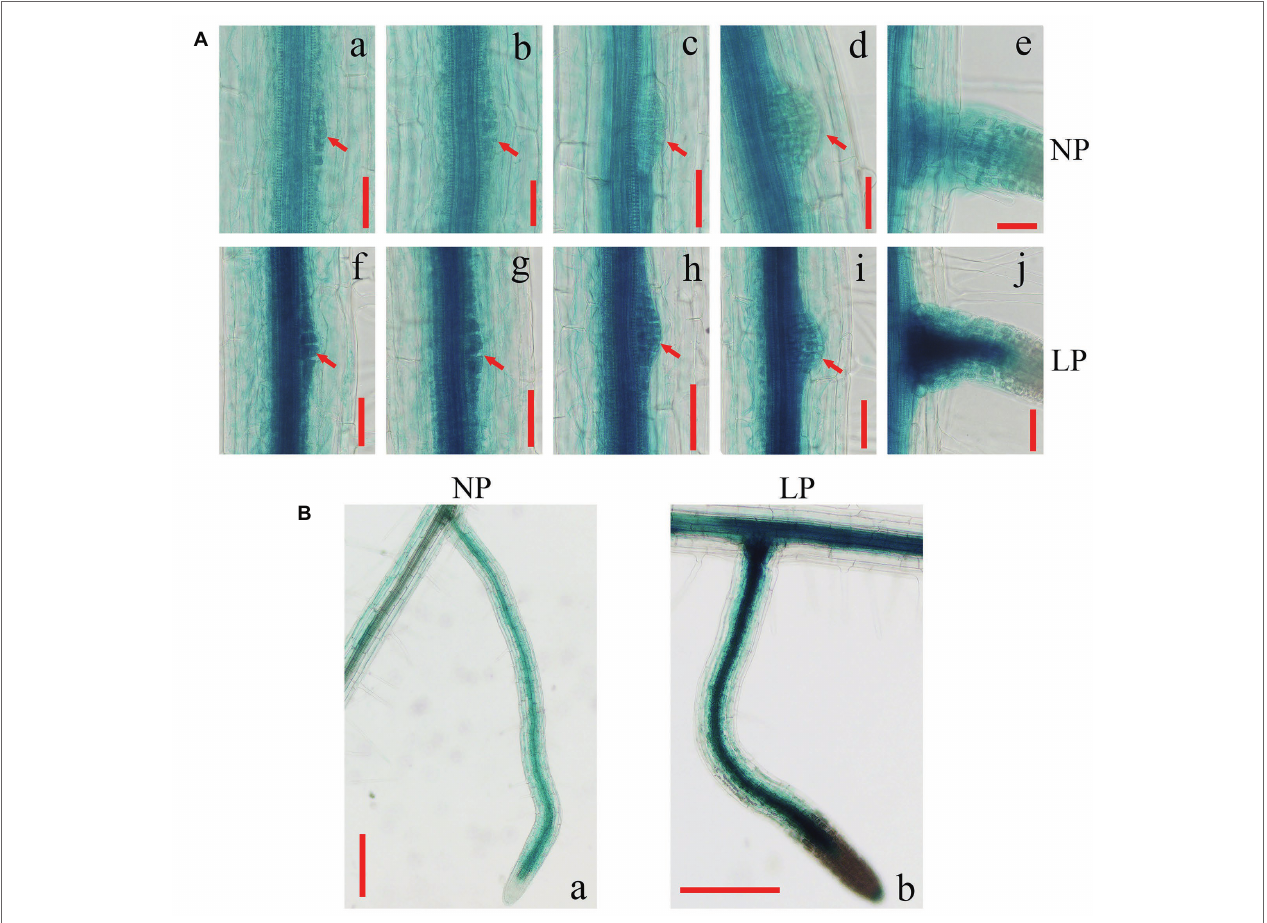
FIGURE 6 | Expression patterns of GmEXLB1::GUS during lateral root development. (A) (a–e) GUS staining at different stages of lateral root emergence in transgenic Aradidopsis under NP conditions (f–j) GUS staining at different stages of lateral root emergence in transgenic Aradidopsiss under LP condition. Red arrows indicate primordium margins. The scale bar = 50 μm. (B) GUS staining of mature lateral roots in transgenic Arabidopsis under NP and LP conditions. The scale bar = 200